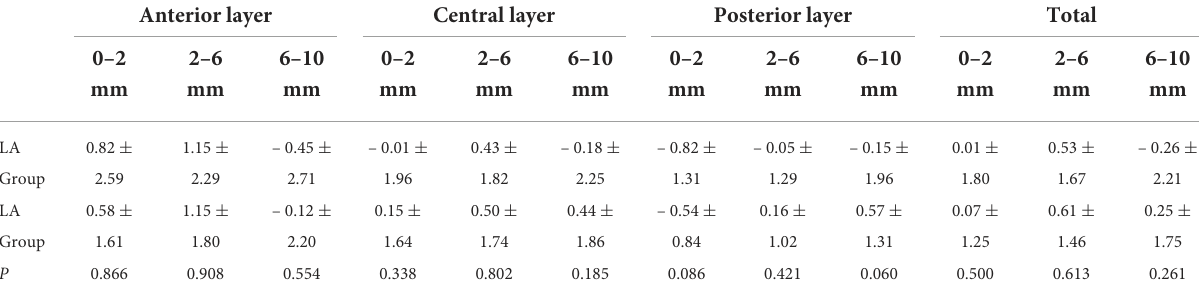
TABLE 4 Changes in corneal densitometry at 6 months after